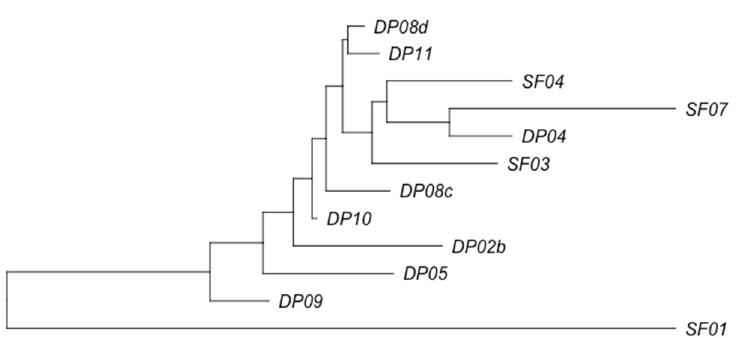
Figure 2. Phylogenetic tree obtained for sequences of amplicons generated with Lactococcus 936 phage-type primers with metagenomic DNA from curd cheeses from dairy plants (DP-) and spontaneous in-house fermentations (SF-).